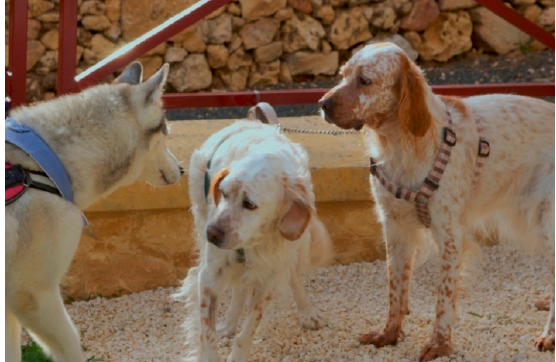
Figure 12. Source: Shutterstock 1496835971.